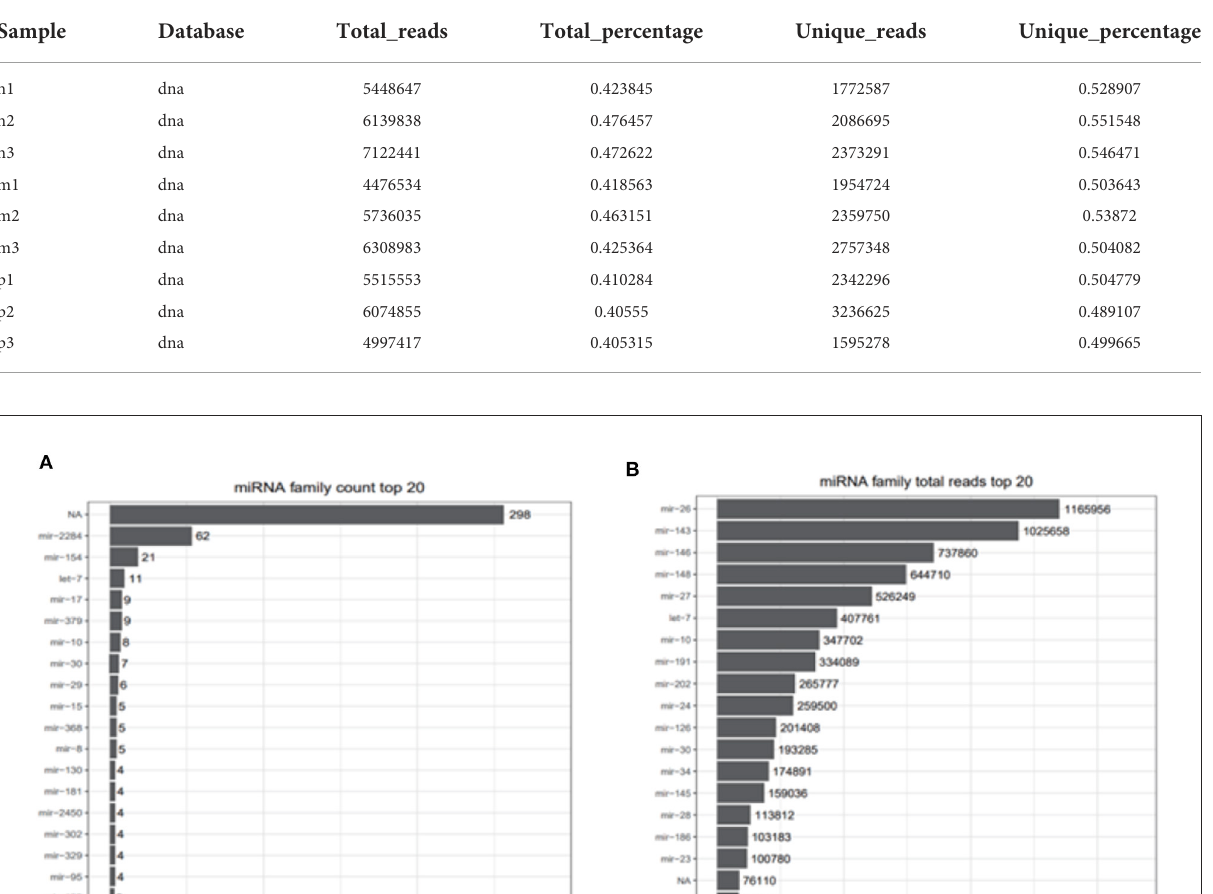
TABLE 2 The result of reads mapped to the reference genome.